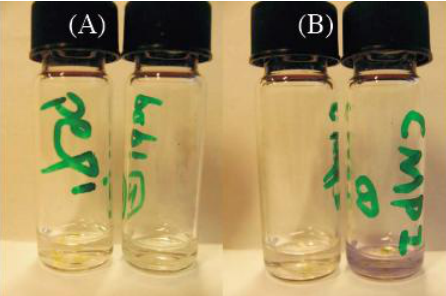
Figure 3. Results of the photodegradation of two perovskites ( A ) PEPI (containing a phenyl ring) and ( B ) a lead perovskite CMPI (alkyl based), both immersed in cyclohexane. On the left stand the vials before irradiation, and on the right after irradiation. The colour comes from a starch-based iodine revealing substance, and shows the relative release of traces of molecular iodine. The CMPI alkylammonium based perovskite photodegradation releases a quite discernible and rather larger amount of iodine than the PEPI phenylammonium based perovskite.